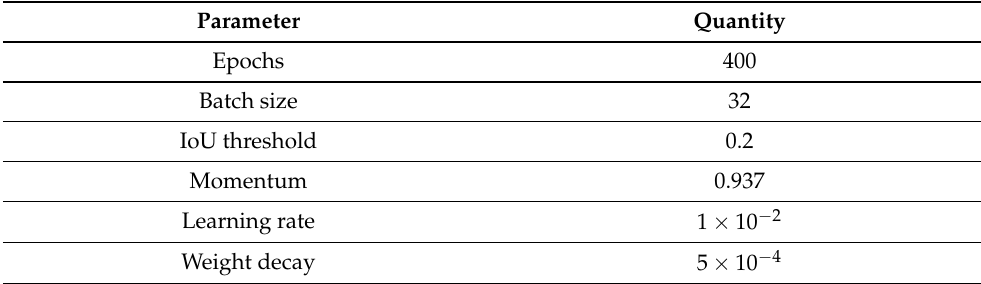
Table 1. The main training